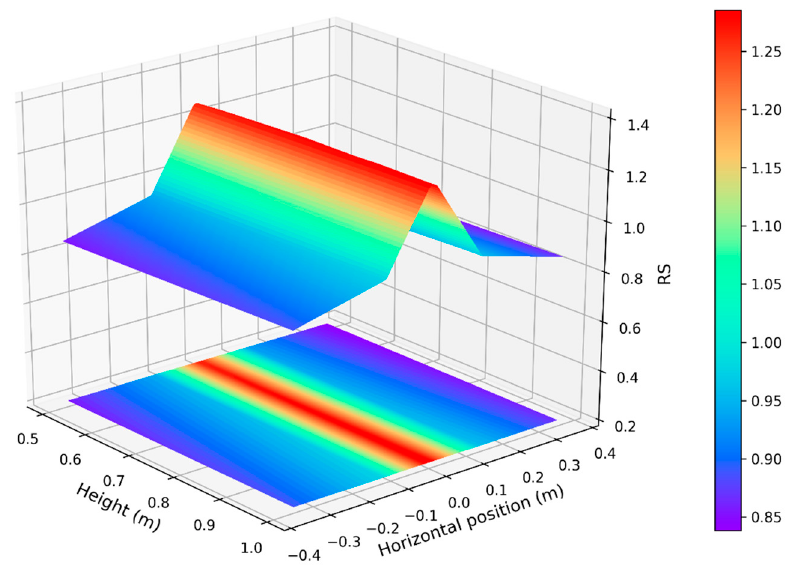
Figure 7. Visualization of RS distribution.